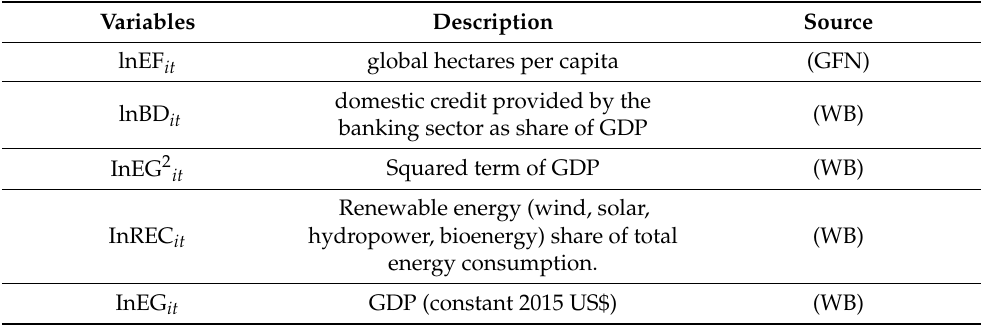
Table 1. Description and sources of